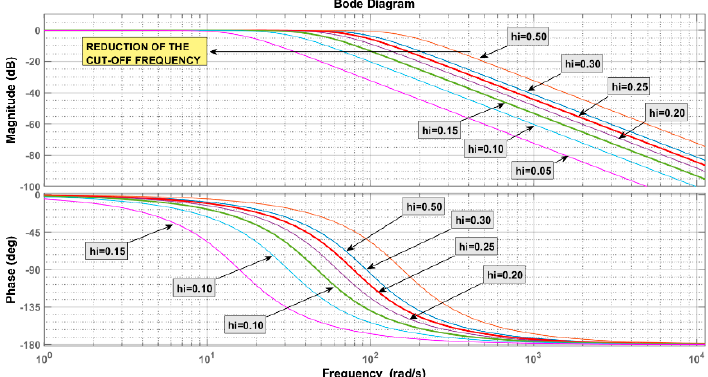
Figure 7. Magnitude and phase bode plots for the LPF capability of SOGI1 and SOGI2, through the variation of h i .